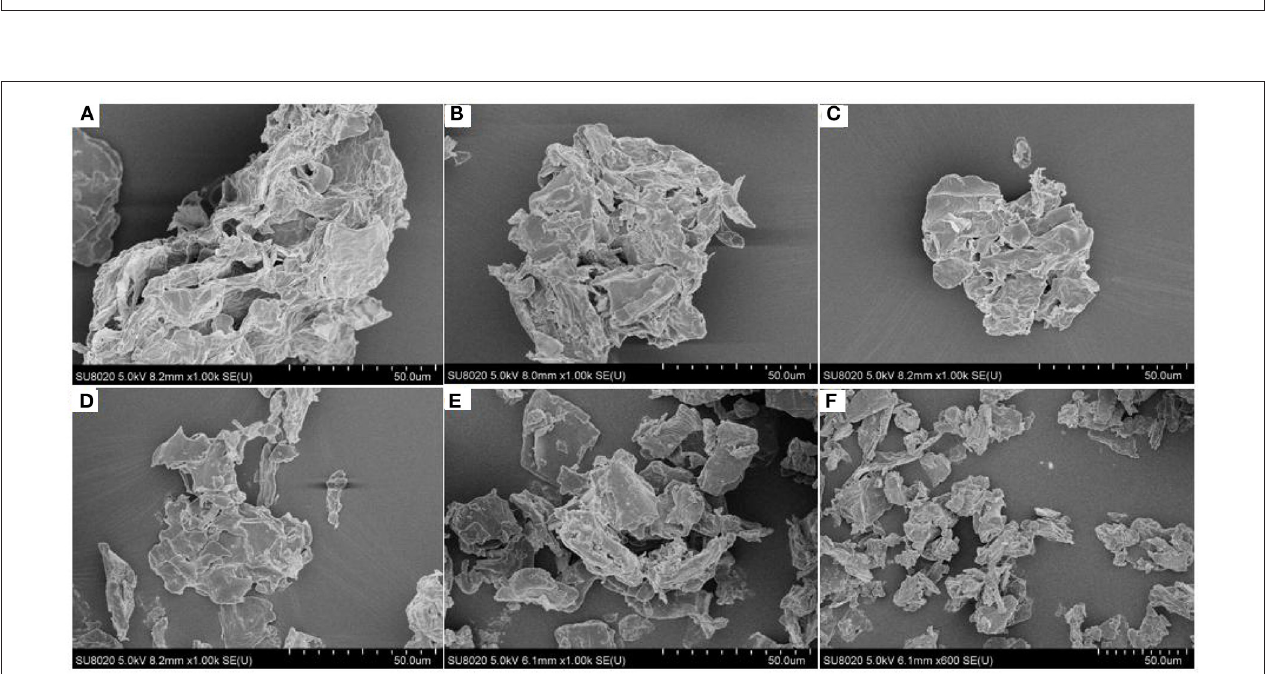
FIGURE 3 | The SEM of CK (A) , 200 mesh (B) , 250 mesh (C) , 300 mesh (D) , 350 mesh (E) , and 400 mesh (F) at magnification 1000 × .